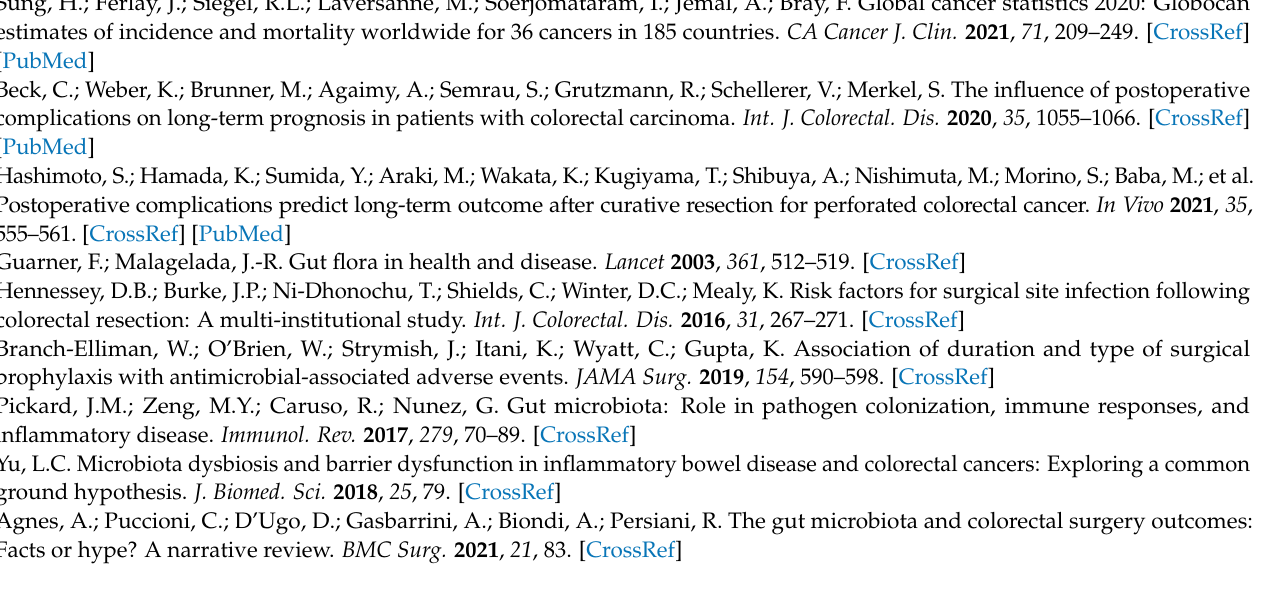
checklist. Table S3: Search strategy. Table S4: Characteristics of included studies (ordered by study ID). Table S5: Characteristics of excluded